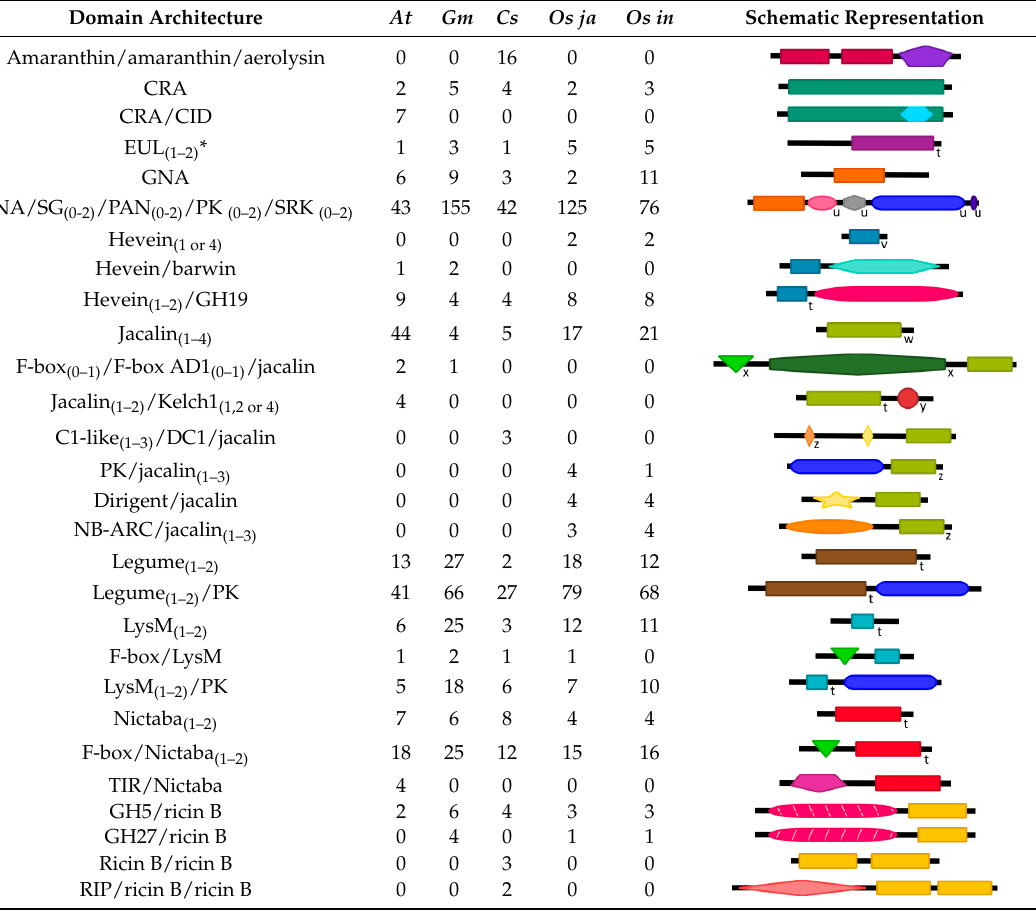
Table 2. Most prevalent domain architectures in Arabidopsis thaliana ( At ), Glycine max ( Gm ), Cucumis sativus ( Cs ) and Oryza sativa ssp. japonica ( Os ja ) and indica ( Os in ) 1 . CID: chitinase insertion domain, SG: S-locus glycoprotein, PK: protein kinase, SRK: S-locus receptor kinase, GH: glycoside hydrolase, F-box AD1: F-box associated domain type 1, NB-ARC: nucleotide binding domain shared by Apaf-1, R proteins, and CED-4; TIR: Toll/Interleukin-1 receptor; RIP: ribosome-inactivating protein domain.